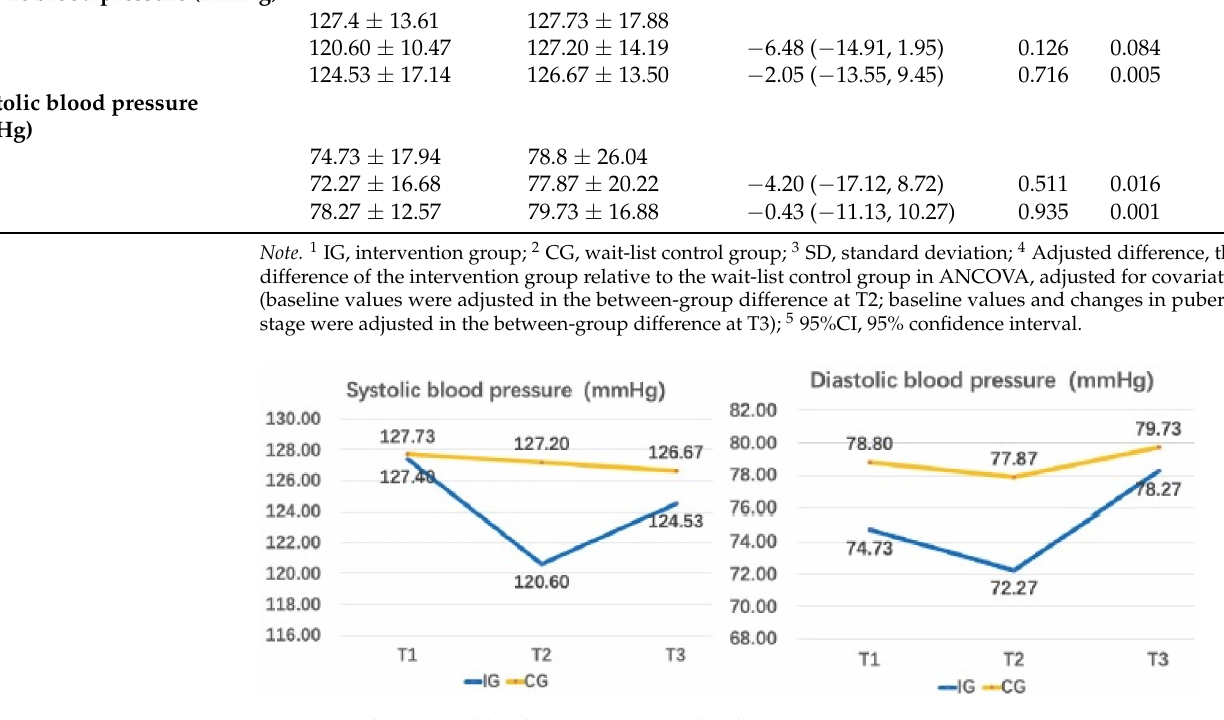
Figure 4. Changes in blood pressure across the three-time